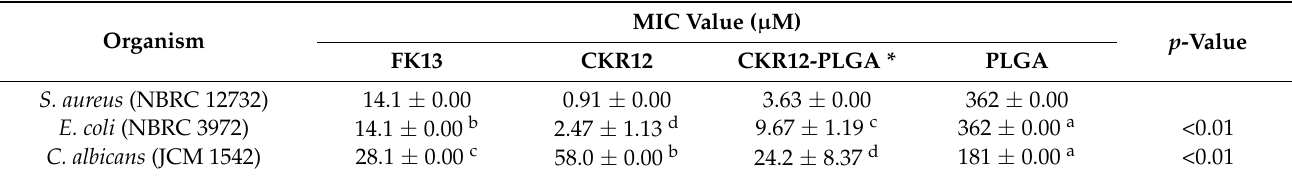
Table 2. Minimum inhibitory concentration (MIC) of FK13, CKR12, and CKR12-PLGA against microorganisms. The MIC values (µM) were determined as the average values obtained from three experiments.